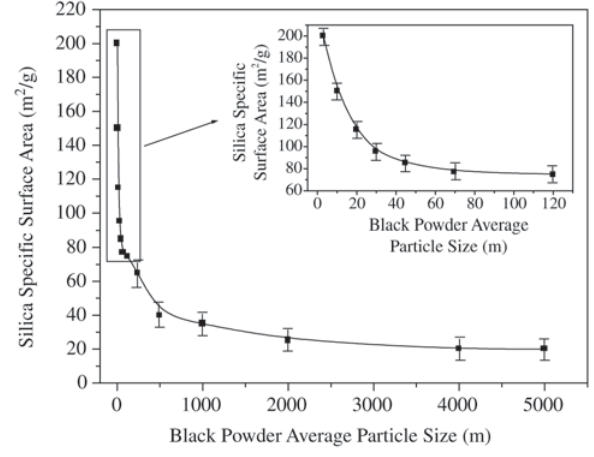
Figure 4 . Dependence of the specific surface area of silica on the average particle size of black powder calcined at 700 °C for 360 min.